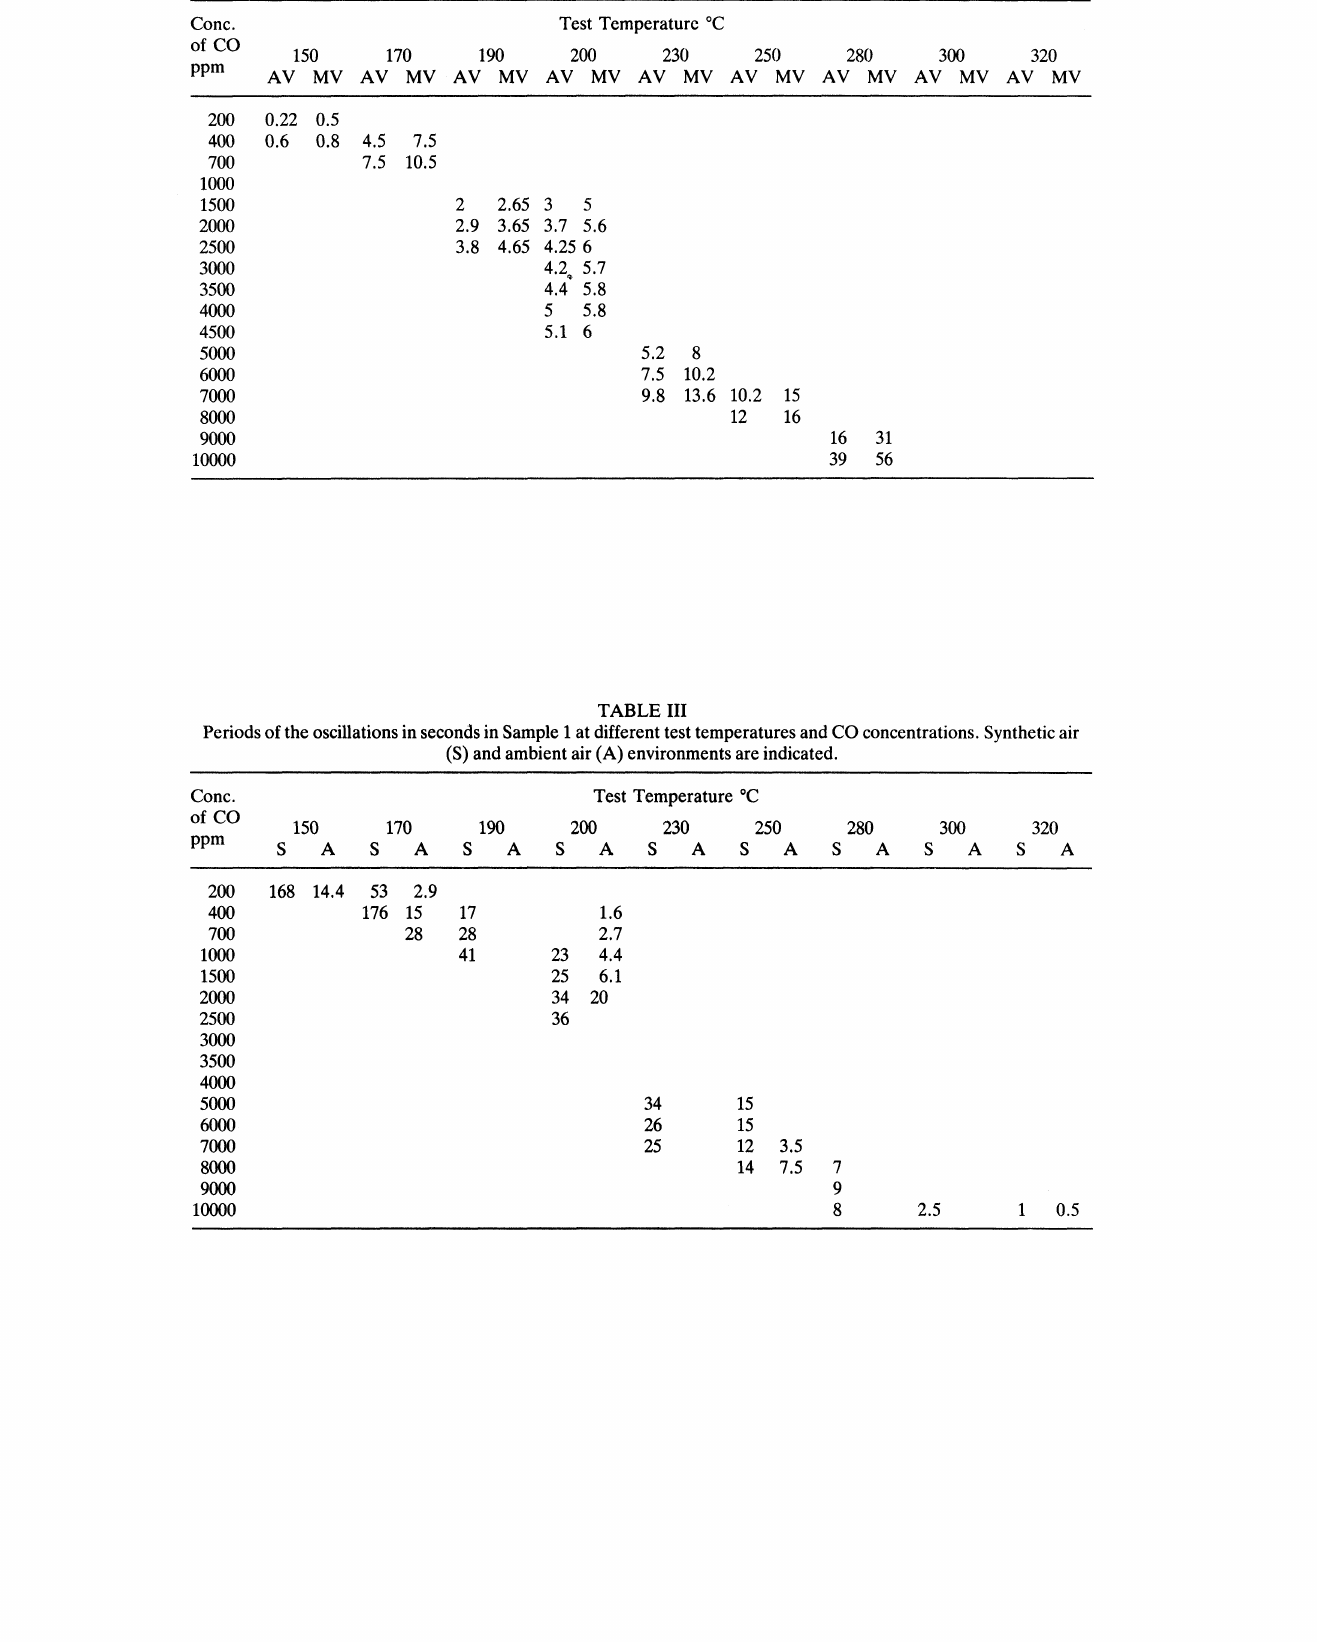
TABLE II Oscillation amplitudes of Sample 2 at different temperatures and CO concentrations in synthetic air. The amplitude value (AV) and the maximum value (MV) of the oscillating current in pA are given. Conc.